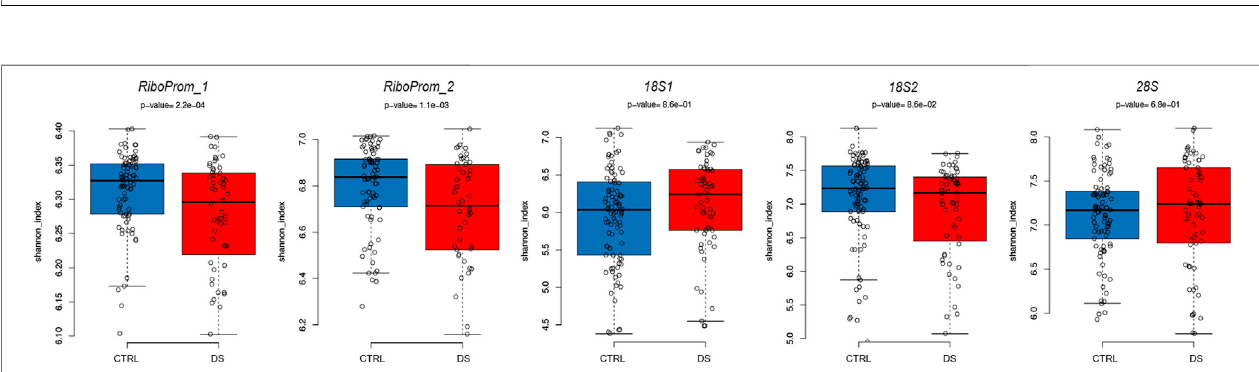
FIGURE 4 | Epihaplotype diversity of the rDNA promoter in DS. For RiboProm_1, RiboProm_2, 18S1, 18S2, and 28S target regions, the boxplots report the Shannon diversity index in CTRL and DS. P -values were determined by the ANOVA test with correction for age, batch, and